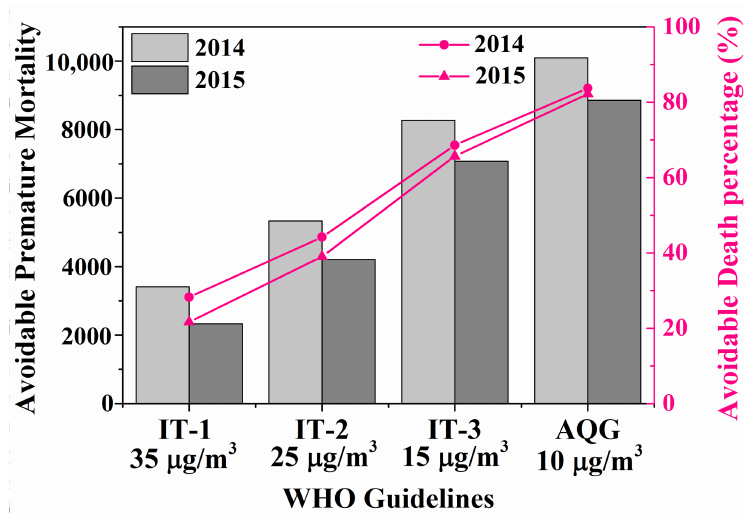
Figure 6. Potentially avoidable premature mortality and relative percentage if the PM 2.5 concentrations were reduced to the World Health Organization (WHO) three interim targets (ITs) and air quality guidelines